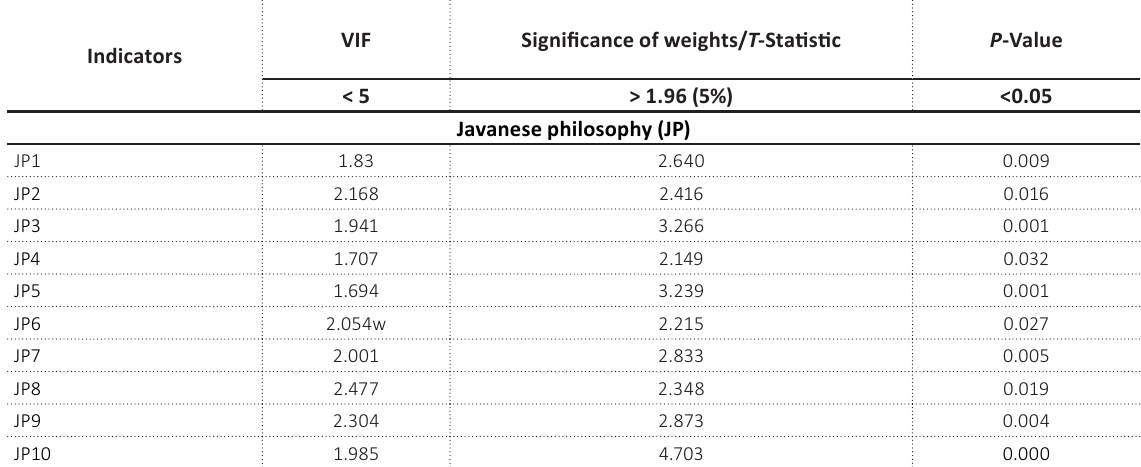
Table 2. Formative